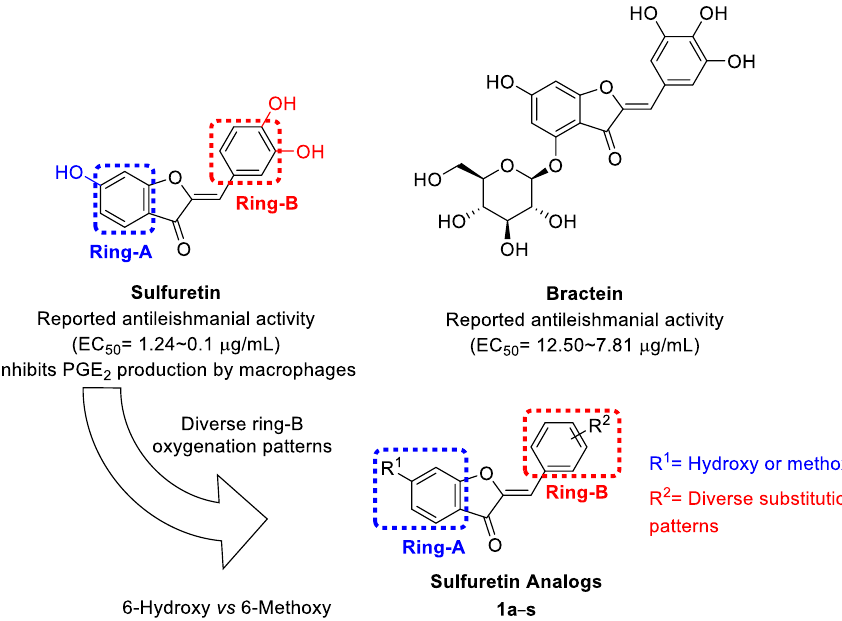
Figure 1. Natural aurones with reported antileishmanial activity and rational for development of antileishmanial sulfuretin analogs. Table 1. List of sulfuretin analogs ( 1a − s ) and their known inhibition of PGE 2 production triggered by sulfuretin and its analogs.